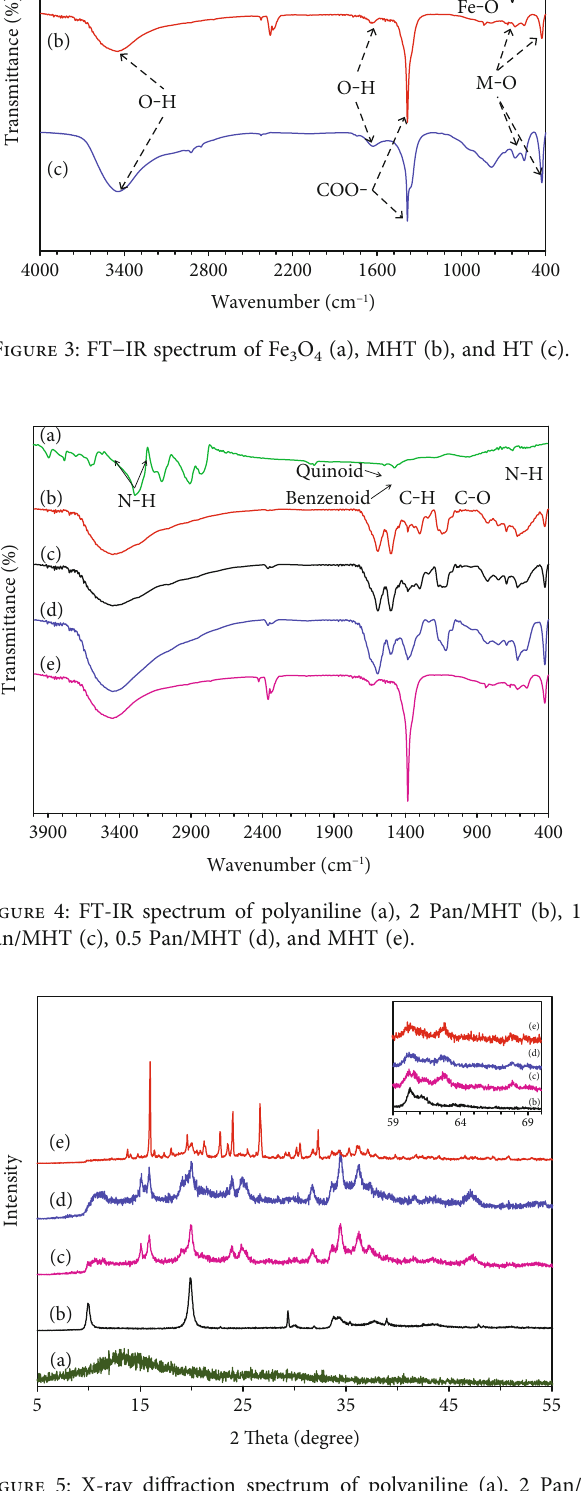
Figure 5: X-ray di ff raction spectrum of polyaniline (a), 2 Pan/ MHT (b), 1 Pan/MHT (c), 0.5 Pan/MHT (d), and MHT (e).